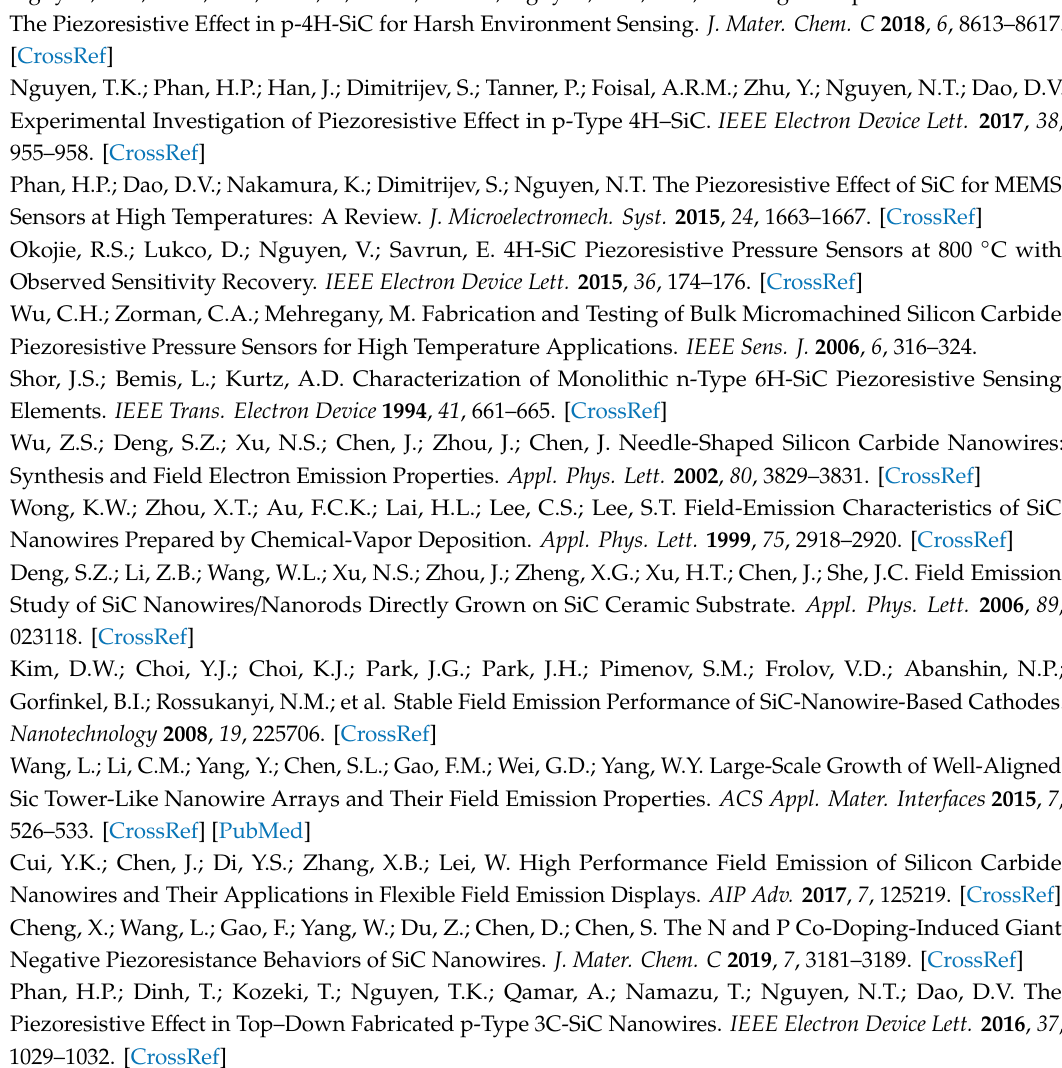
Figure S1: ( a ) A representative EDX spectrum of SiC nanowire ( b ) A typical element mapping of C within the SiC nanowire. ( c ) A typical element mapping of Si within the SiC nanowire. ( d ) A typical high angle annular dark field imaging (HAADF) of SiC nanowire by scanning transmission electron microscope (STEM), especially, the red circle area was test position of EDX spectrum shown in figure ( a ). Figure S2: ( a ) SEM image of SiC nanowire in the original state ( b ) SEM image of SiC nanowire in recovery state after removing drawing force. ( c ) Current versus voltage (I-U curves) of SiC nanowire for conductivity in original states, stretch 2 state, and recovery